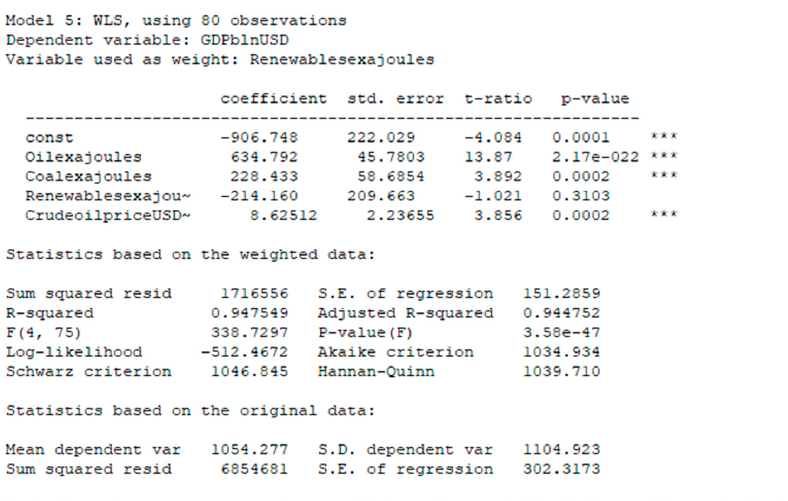
Figure 4. Testing the model for heteroscedasticity.